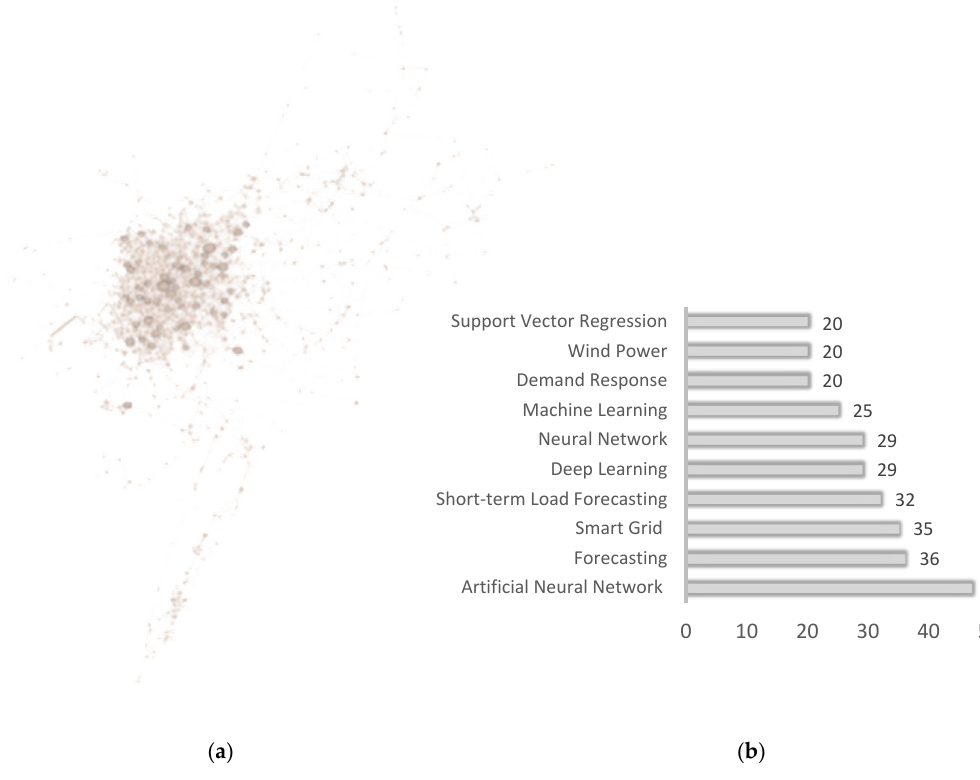
Figure 16 . Prediction algorithms applied to the power community : ( a ) manuscripts published, ( b ) Figure 16. Prediction algorithms applied to the power community: ( a ) manuscripts